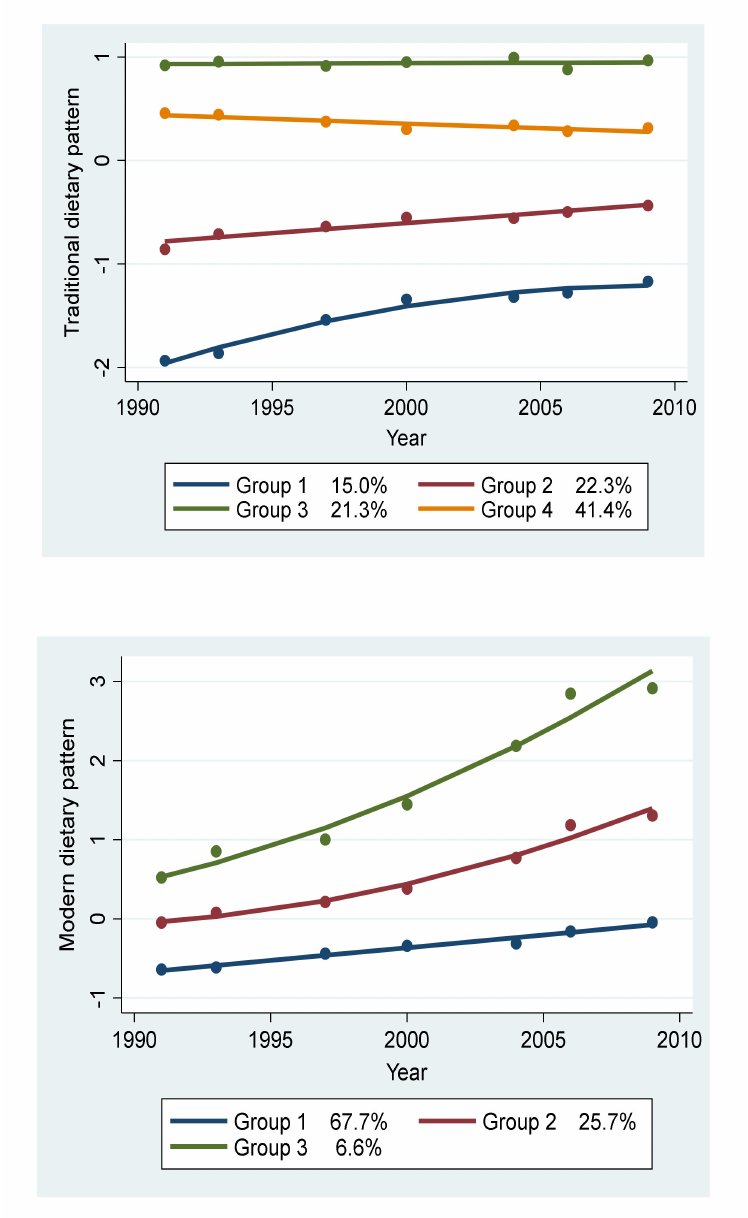
Figure 1. Dietary pattern trajectory groups between 1991 and 2009 among adults participating in the China Health and Nutrition Survey ( n = 10,495) * . * All the included participants had at least three waves of dietary intake